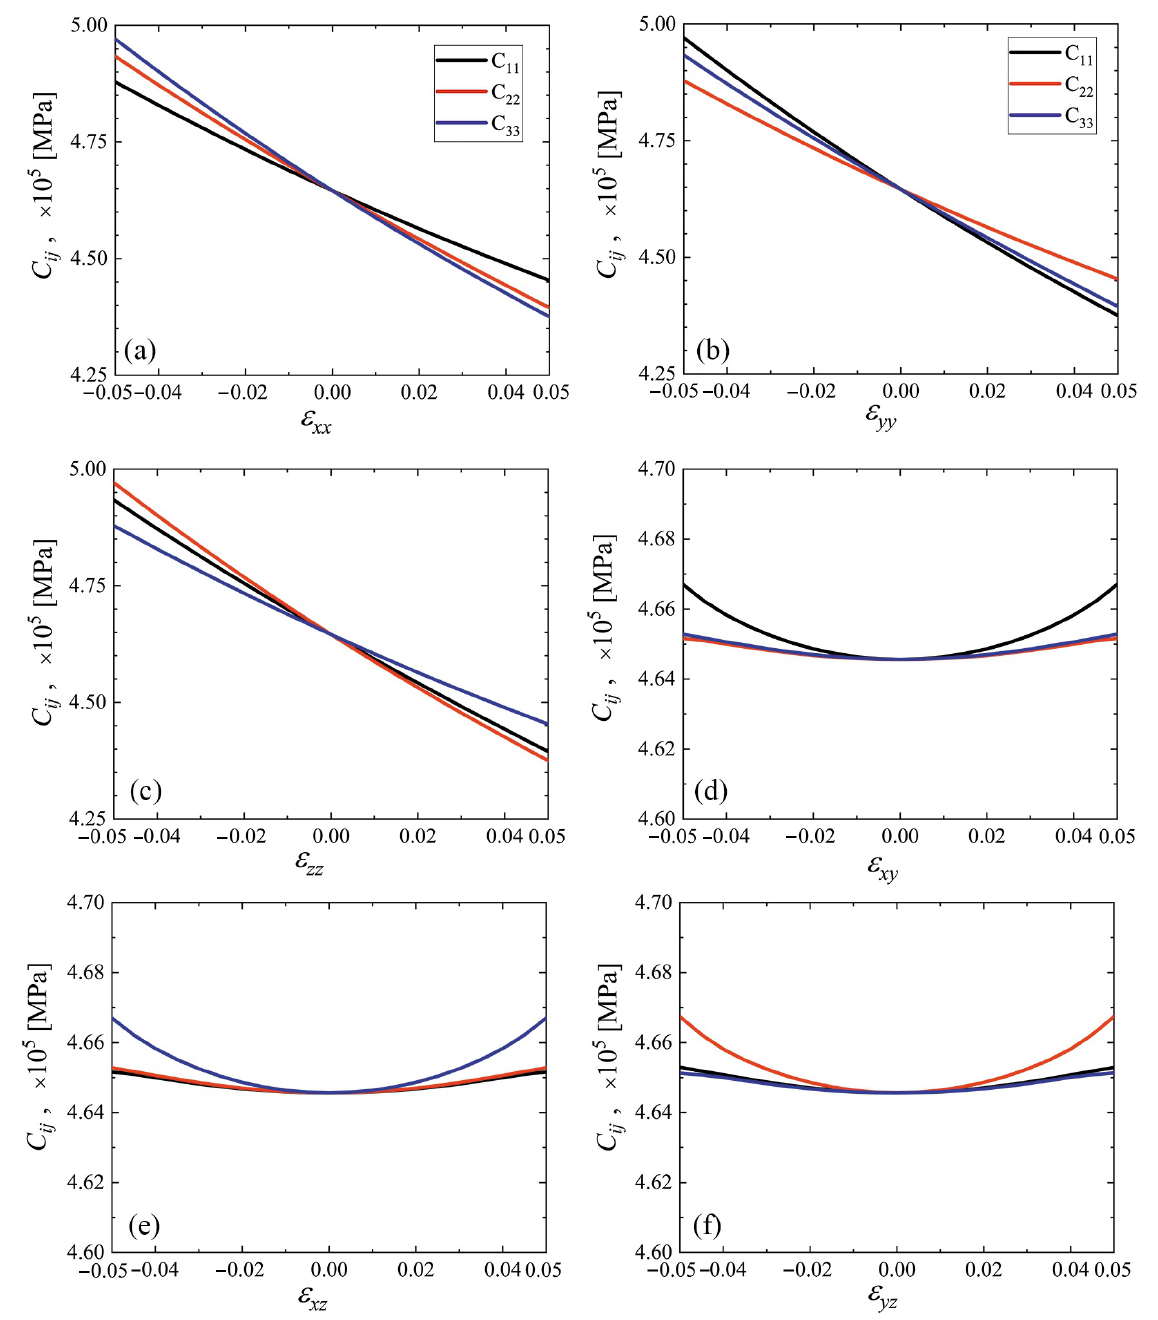
Figure 7. Elastic constants C 11 , C 22 , and C 33 as the functions of strain for cubic cubene crystal (black, red, and blue lines, respectively). Only one component of the strain tensor is varied, the rest are equal to zero. Panels ( a – f ) correspond to changing ε xx to ε yz ,